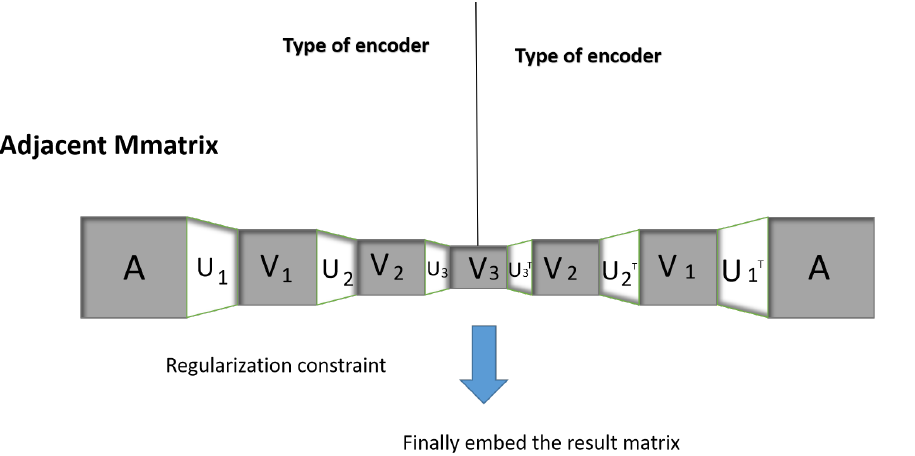
Figure 1. Framework diagram of the MSDA-NMF model.